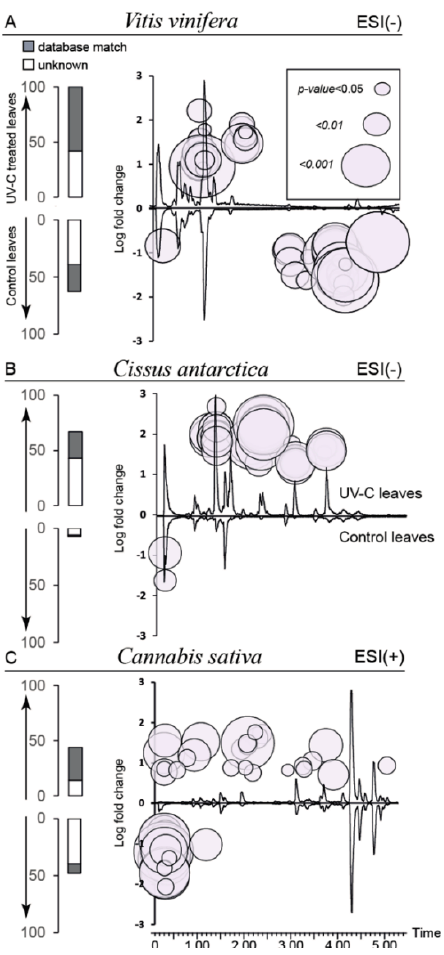
Figure 3. Right : LC-MS chromatogram of control (BPI trace) ( bottom ) and UV-C-treated leaves ( top ). Superimposed are the main features plotted according to their mean log-fold change between control and UV-C treatment. The area of the circle is inversely proportional to the p -value of an unpaired T-test, α = 0.05. Left : bar plot showing the number of features up- and down-regulated in UV-treated leaves (>5-fold intensity changes). Blank bar shows unidentified features; grey bar shows features with a database